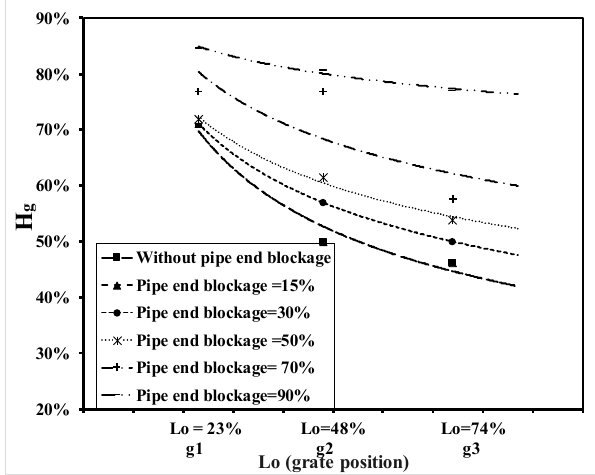
Figure 12. Relationship between Hg and LO for different relative blockage heights at Q = 3.30L/sec.